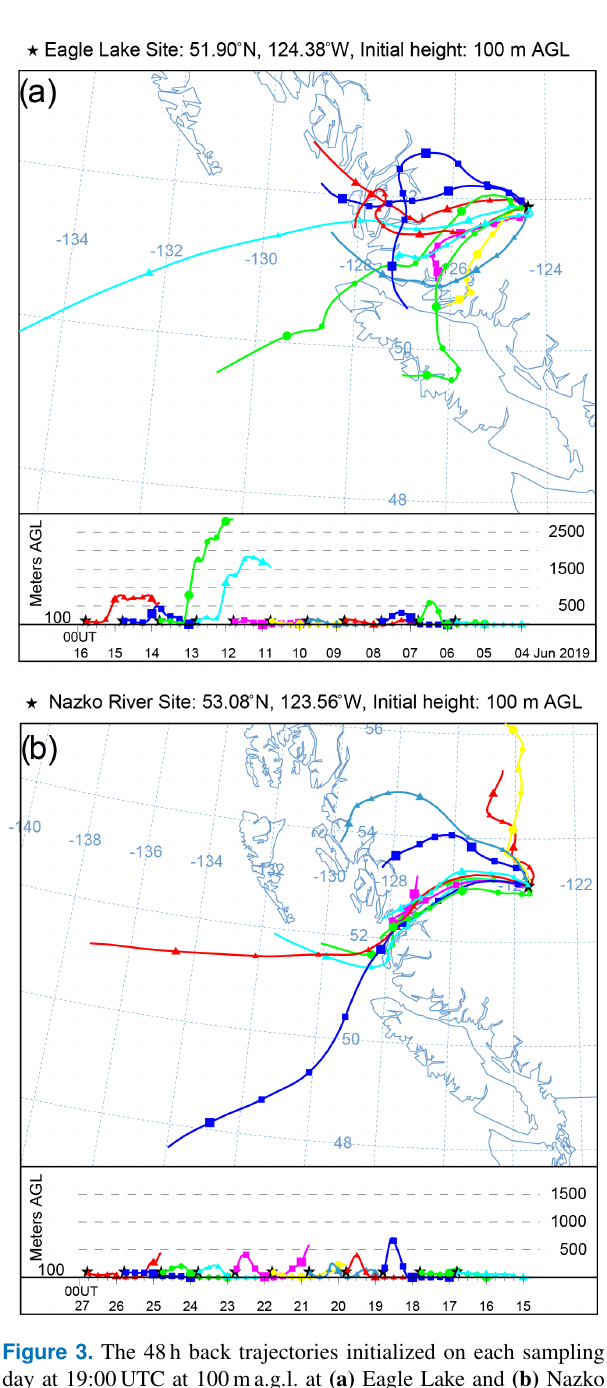
Figure 3. The 48h back trajectories initialized on each sampling day at 19:00UTC at 100ma.g.l. at (a) Eagle Lake and (b) Nazko River.